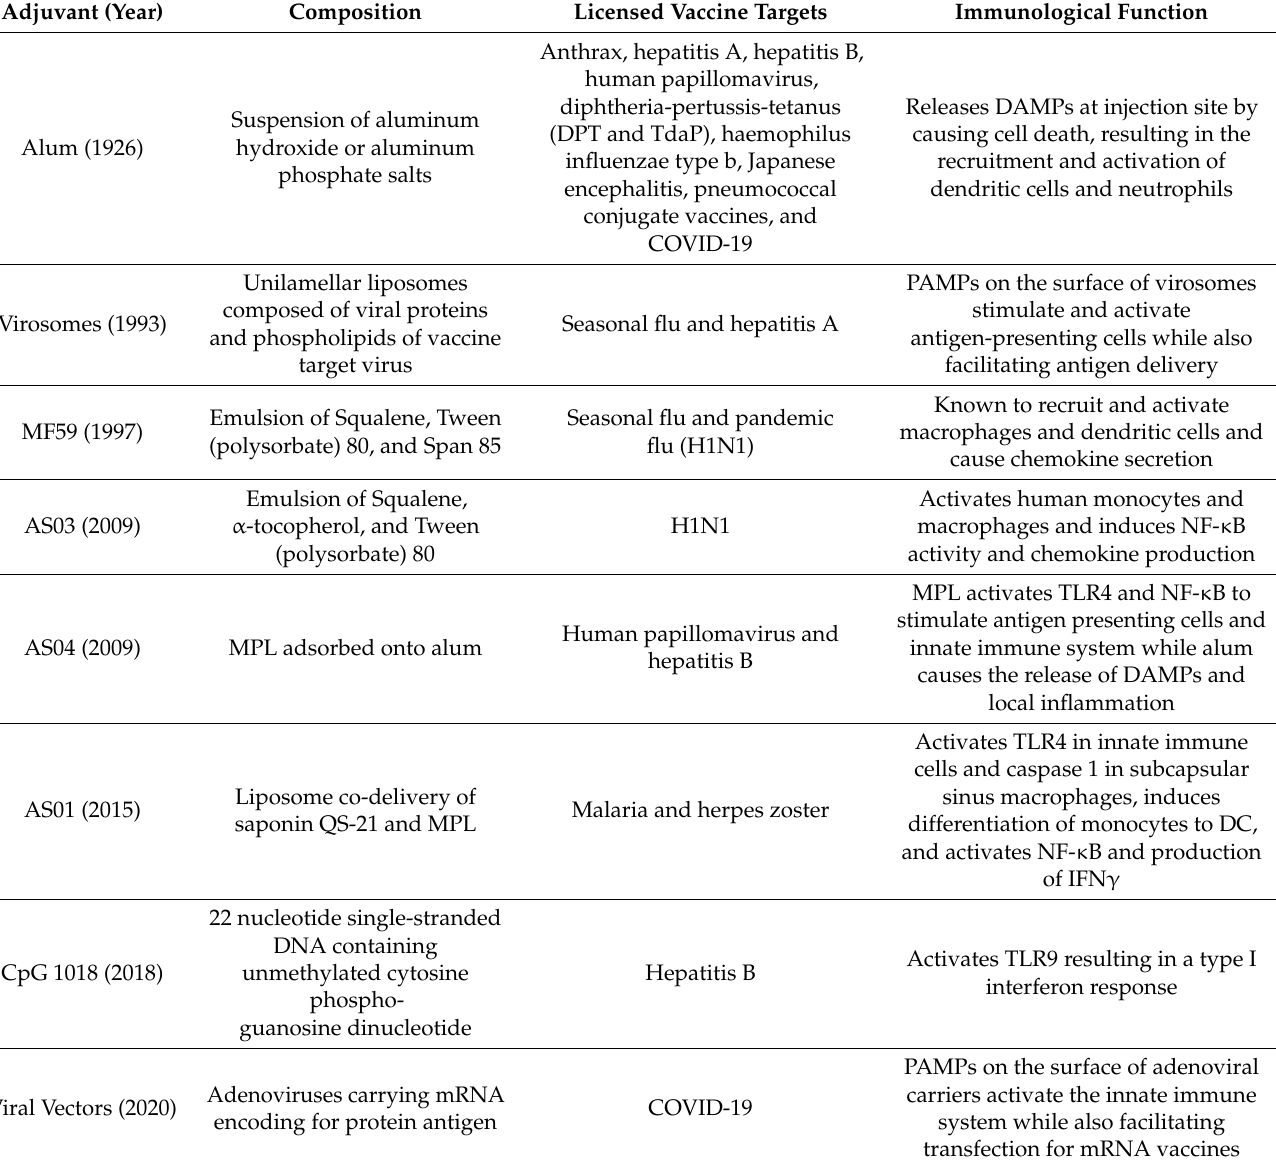
Table 1. List of adjuvants in vaccines approved for human use with their composition and known mechanism of action. Adjuvant